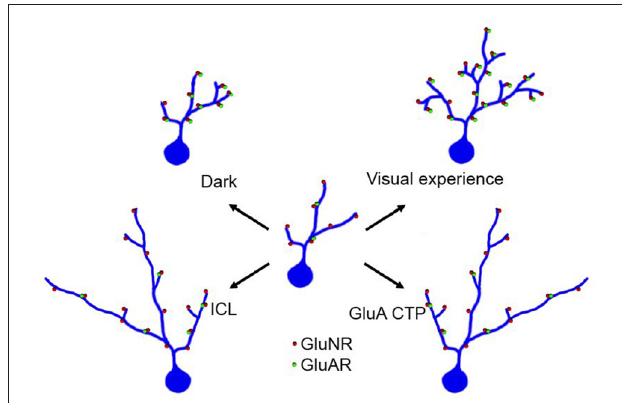
FIGURE 4 | Visual experience enhances dendritic arbor development through effects on excitatory and inhibitory synaptic transmission. An immature optic tectal neuron is schematized in the center of the figure and structural changes in dendritic arbor in response to different conditions are shown radiating from the center. Under conditions in which tadpoles receive visual stimulation, optic tectal neurons elaboration complex dendritic arbors and their excitatory synapses mature and increase in strength by increasing the ratio of AMPA/NMDA type glutamate receptors. Raising tadpoles in the dark decreases elaboration of the dendritic arbor. Expressing GluA C terminal peptides (GluA CTP) impairs AMPA receptor trafficking, decreases excitatory synapses and decreases complexity of dendritic arbors. Expressing intracellular loop (ICL), which impairs GABA A R residence at synapses and decreases inhibitory synaptic inputs onto tectal neurons, also decreases complexity of dendritic